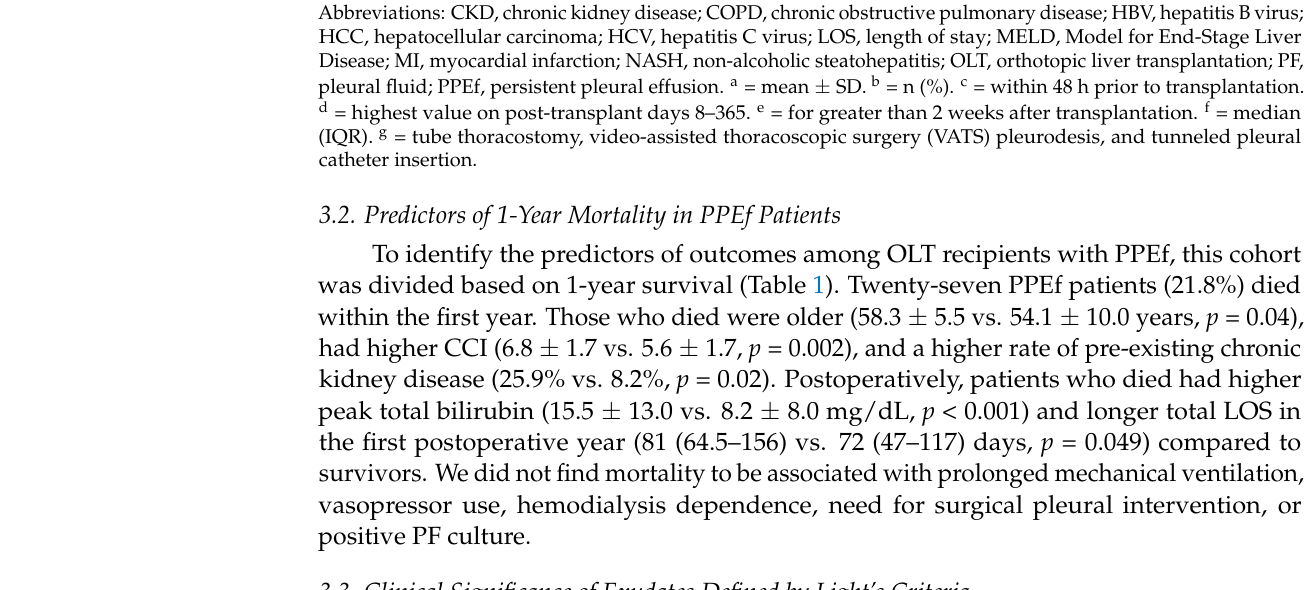
Abbreviations: CKD, chronic kidney disease; COPD, chronic obstructive pulmonary disease; HBV, hepatitis B virus; HCC, hepatocellular carcinoma; HCV, hepatitis C virus; LOS, length of stay; MELD, Model for End-Stage Liver Disease; MI, myocardial infarction; NASH, non-alcoholic steatohepatitis; OLT, orthotopic liver transplantation; PF, pleural fluid; PPEf, persistent pleural effusion. a = mean ± SD. b = n (%). c = within 48 h prior to transplantation. d = highest value on post-transplant days 8–365. e = for greater than 2 weeks after transplantation. f = median (IQR). g = tube thoracostomy, video-assisted thoracoscopic surgery (VATS) pleurodesis, and tunneled